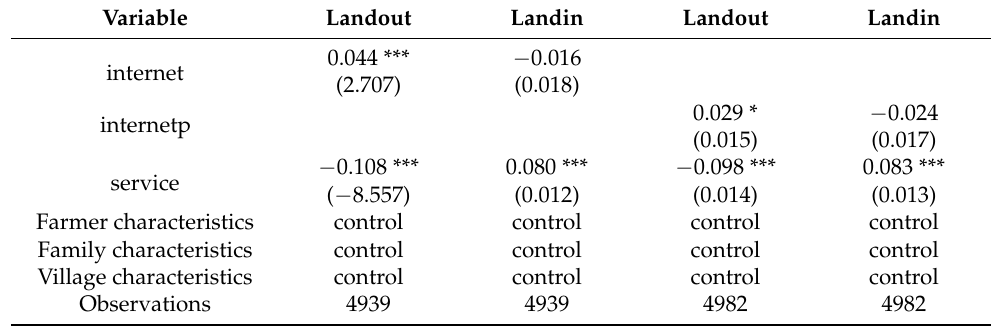
Table 5. Robustness